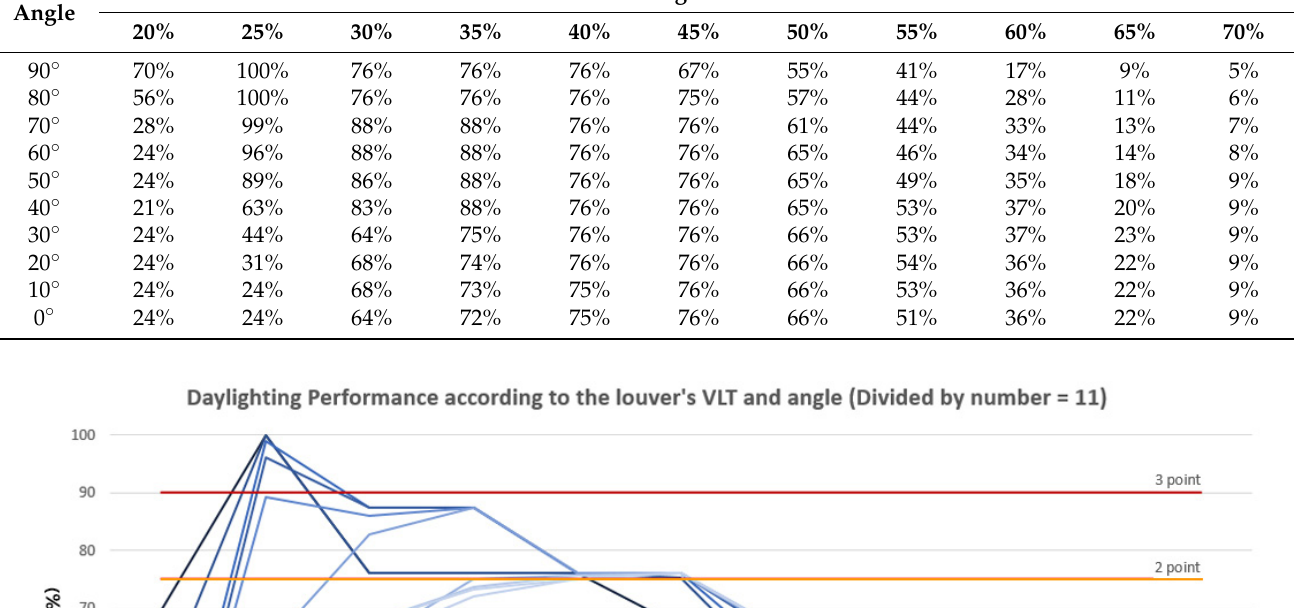
Table 5. Target illuminance achievement rates when the number of divisions of louvers is 11. Table 5 and Figure 6 show target illuminance achievement rates when the number of louvers is 11. When the VLT was 25%, there were only four cases in which three points could be obtained: 90 ◦ , 80 ◦ , 70 ◦ , and 60 ◦ . There were a total of 33 cases where two points Angle could be obtained. There were 37 cases in which two or more points could be obtained. EC Visible Light Transmittance